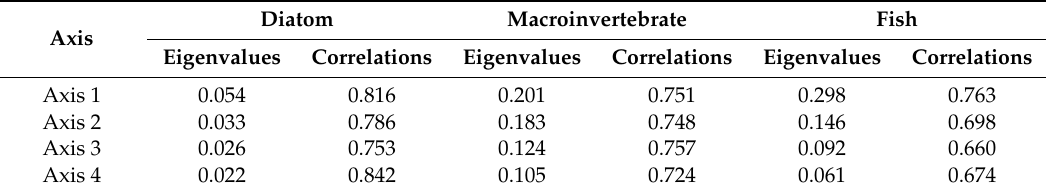
Table 2. Eigenvalues and species-environment correlations of each canonical axis.